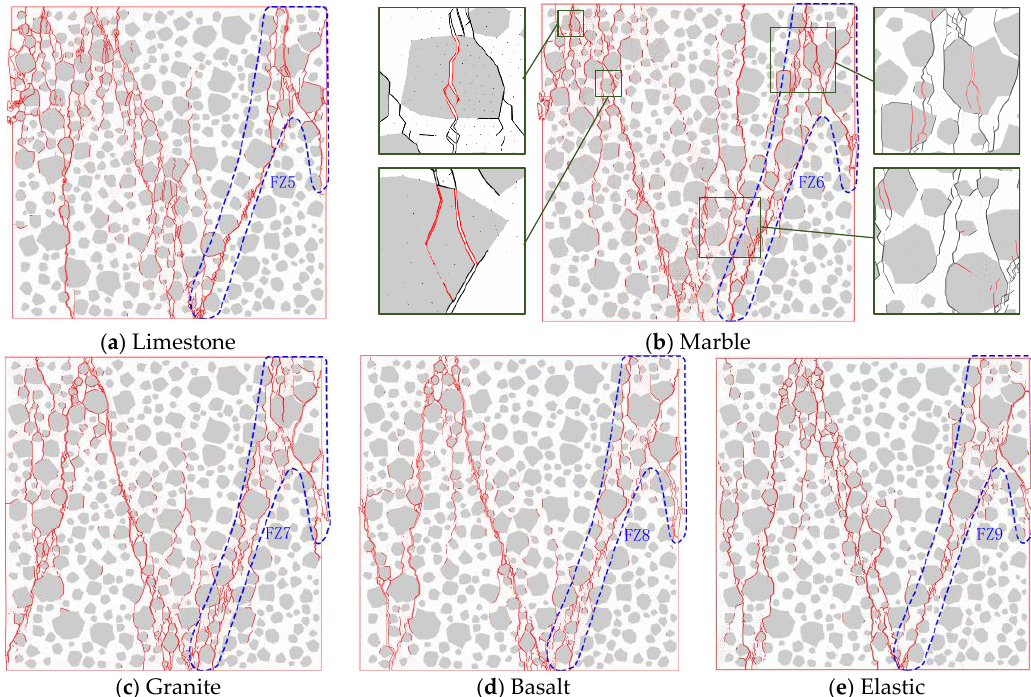
Figure 22. The relationship between strain and the sum of length of AII elements whose SDEG (overall value of the scalar damage variable) values are higher than 0.95.